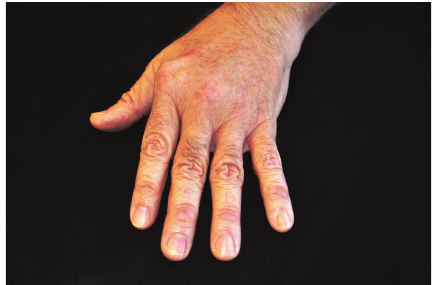
Figure 2: Clinical Photo of left windblown hand demonstrating ulnar drift of the digits at the MCP joint.